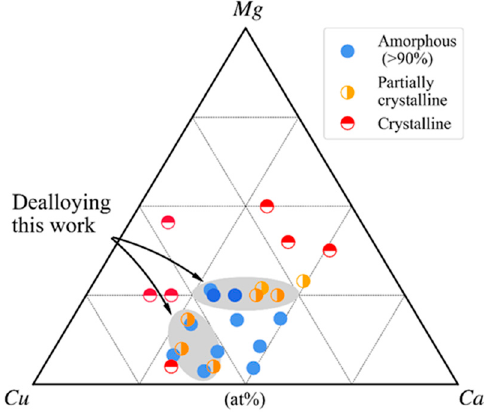
Figure 2. Glass-forming ability of the Cu-Mg-Ca system. All the alloys were obtained by rapid solidification in ribbon shape. Darker colors correspond to the alloys analyzed in this work and lighter color symbols to alloys already reported in reference [38].